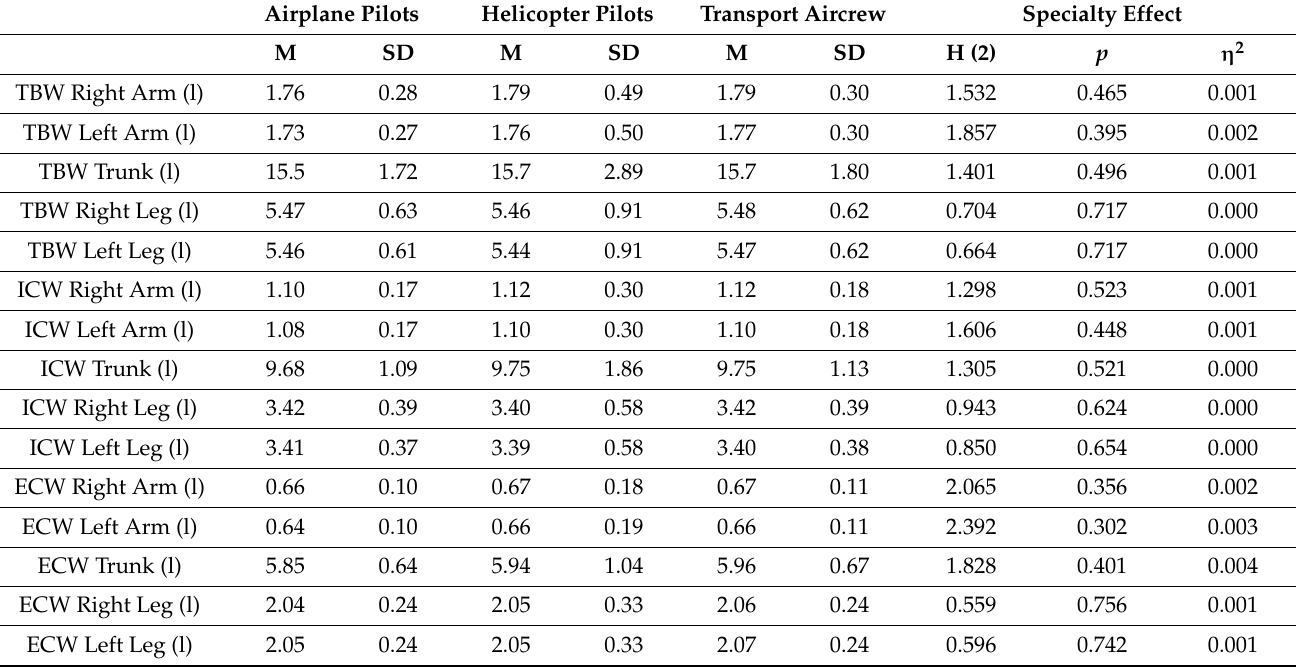
Table 3. Results of body water by body